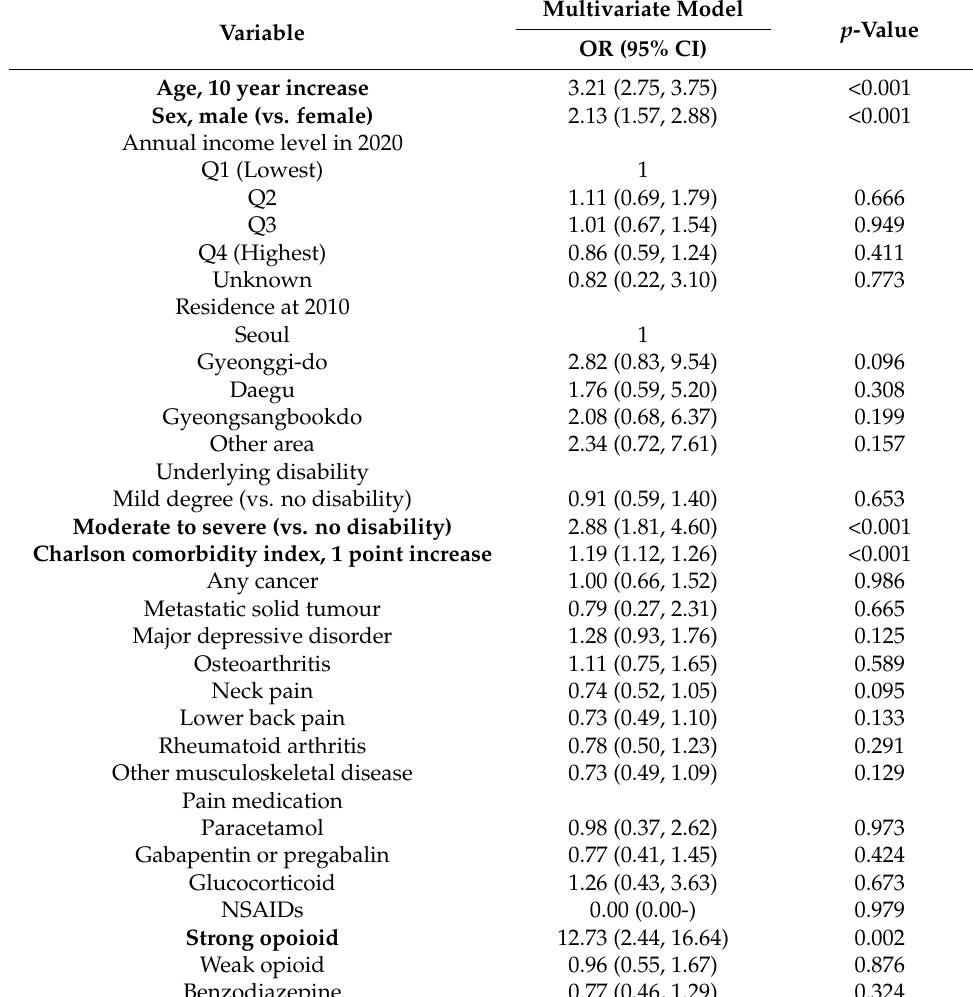
Table 3. Multivariate logistic regression analysis for in-hospital mortality among COVID-19 patients in South